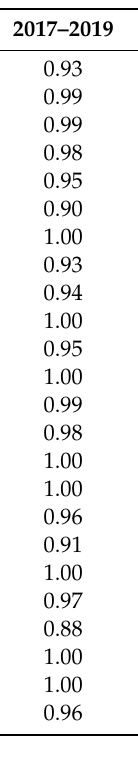
Table 9. Average of windows in the BCC model for each three years.